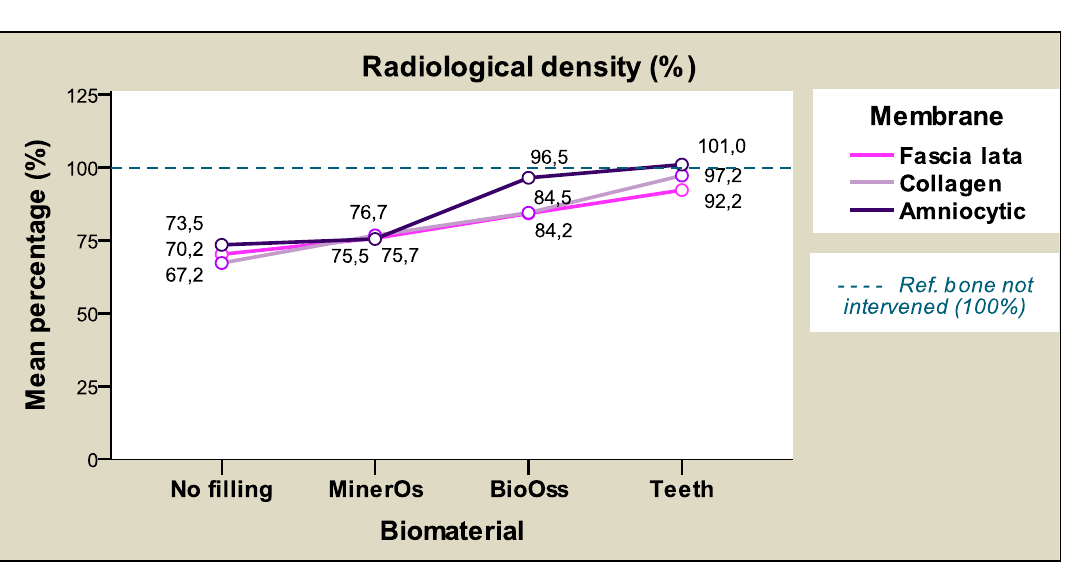
Figure 9 . The radiological density percentages (average) according to filling material and membrane .